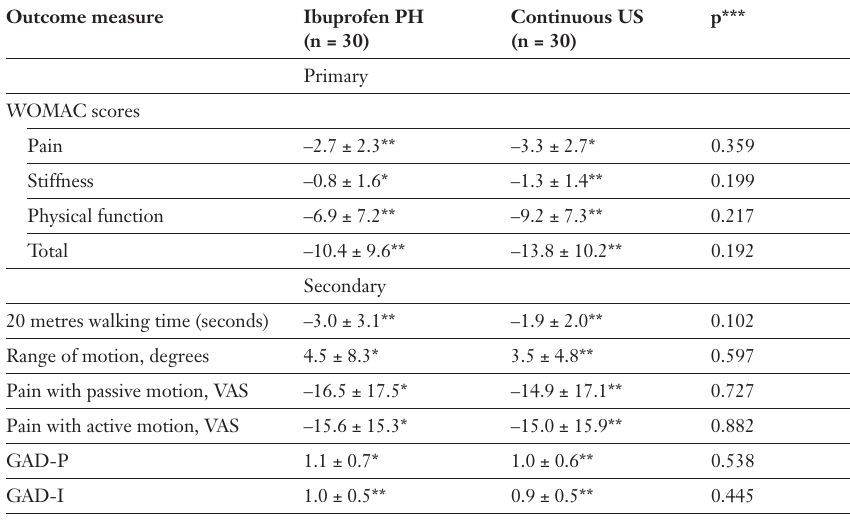
Changes in clinical outcome measures after